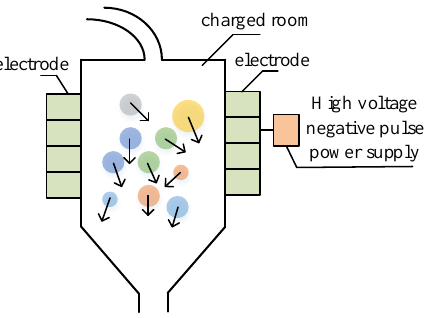
Figure 2. Simplified scheme of composition and principle of charged room.